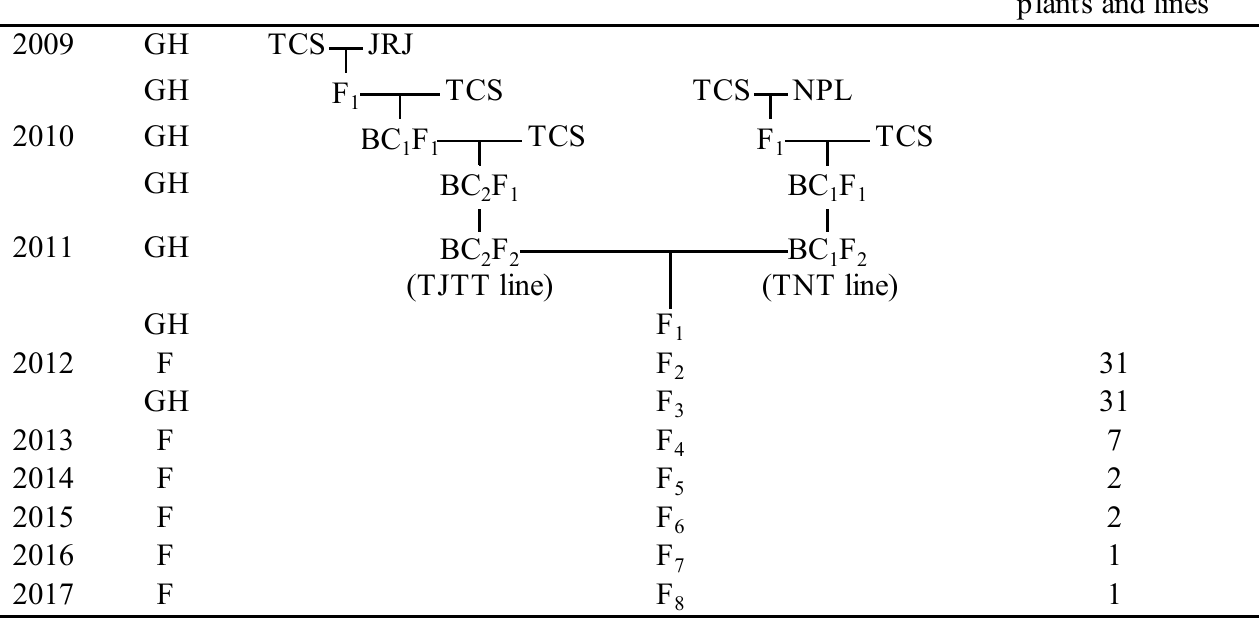
Figure 1. Breeding procedure used in this study. *: GH; greenhouse, F; field. **: TCS; Tachisugata, JRJ; Jarjan, NPL; Nepal555, TJTT line; TCS/JRJ//TCS///TCS (BC 2 F 2 ), TNT line; TCS/NPL//TCS (BC 1 F 2 ).